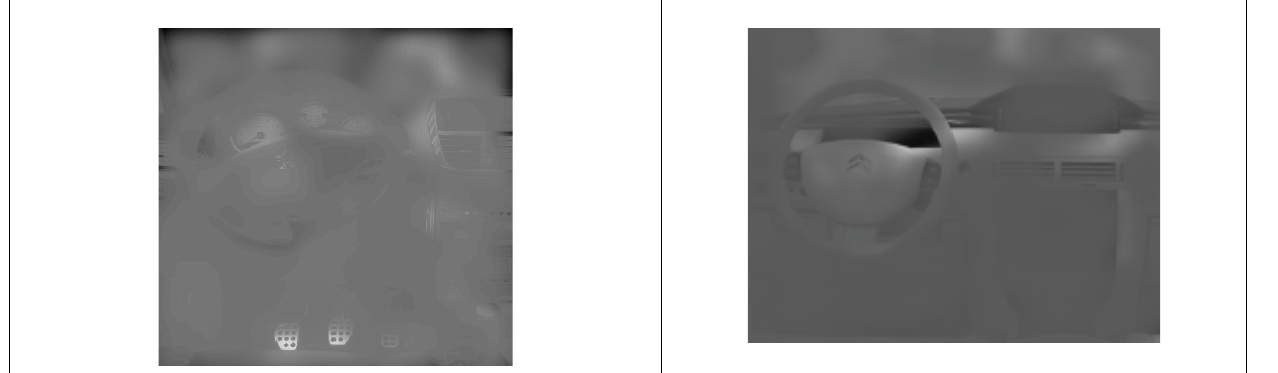
(b) Classification image for C6, assessment of the luxury